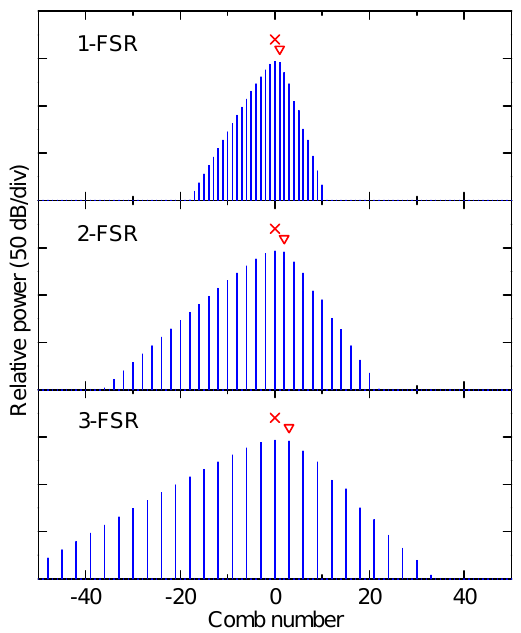
Figure 9: Simulated comb spectra based on normalized LL equation modified to take into account the mode coupling. The resonance shift induced by mode coupling is represented by an additional phase shift to the corresponding frequency component in the fre- quency domain of the split-step Fourier procedure. By applying an additional phase shift to the sidebands (marked with “ ∇ ”) 1-, 2-, and 3-FSR away from the pump (marked with “×”), combs spaced by 1, 2, and 3 FSRs are generated, respectively. The simulation parame- ters are η = 1 , ∆ = 2.45 , S = 3.45 , ∆ϕ = −5.31 , FSR = 0.0054 . LL: Lugiato–Lefever; FSR: free spectral range.